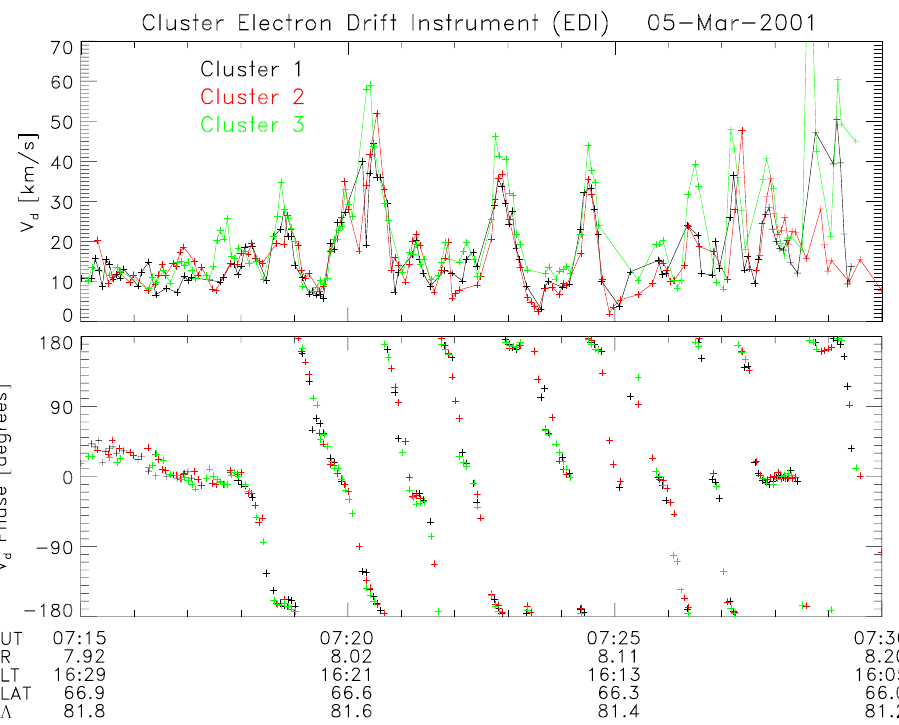
Fig. 13. Drift velocity magnitude and phase in the gyro plane, for 07:15 to 07:30 on 5 March, demonstrating full 360 ◦ rotations of the drift velocity